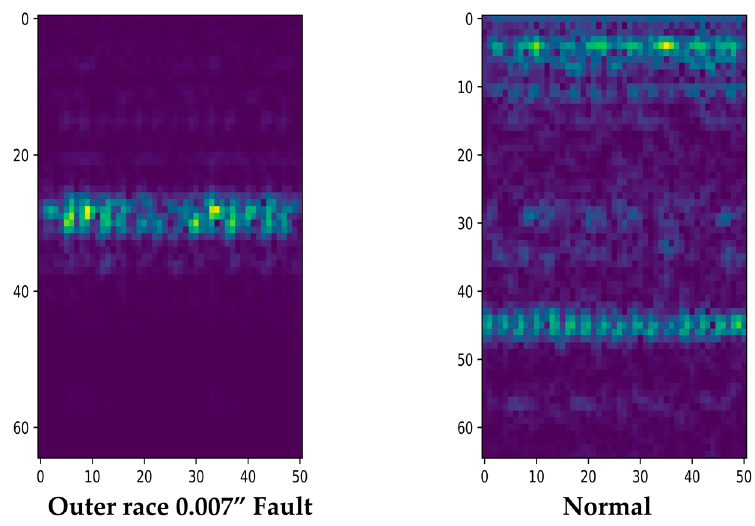
Figure 3. Example Spectrograms of Bearing Damage in Normal and Outer Direction Conditions. When generating a spectrogram in the time–frequency domain, the fault frequency component is expressed strongly in the spectrogram of the defective bearing. Normal bearings do not exhibit fault frequencies and generally have a flat spectrogram value.